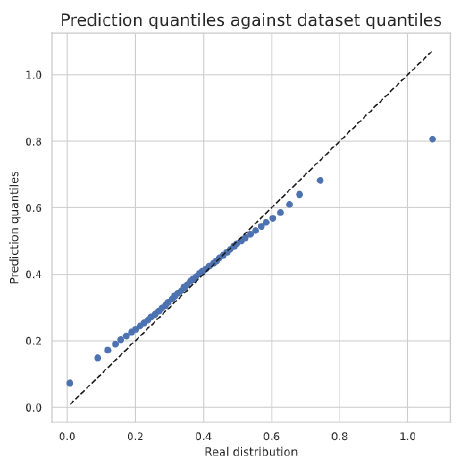
Figure 15. Hybrid CNN prediction quantiles versus real